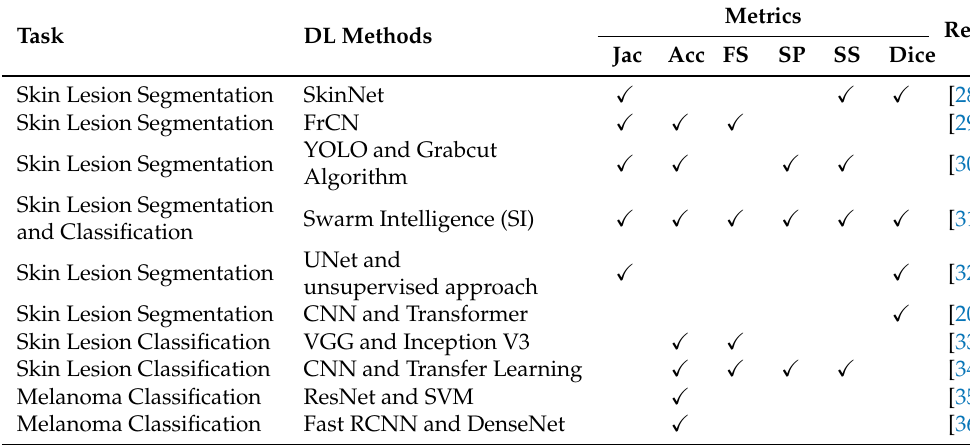
Table 2. Summary of tasks, DL methods, and the evaluation metrics. Jac : Jaccard index, Acc : accuracy, FS : F1-score, SP : specificity, SS :